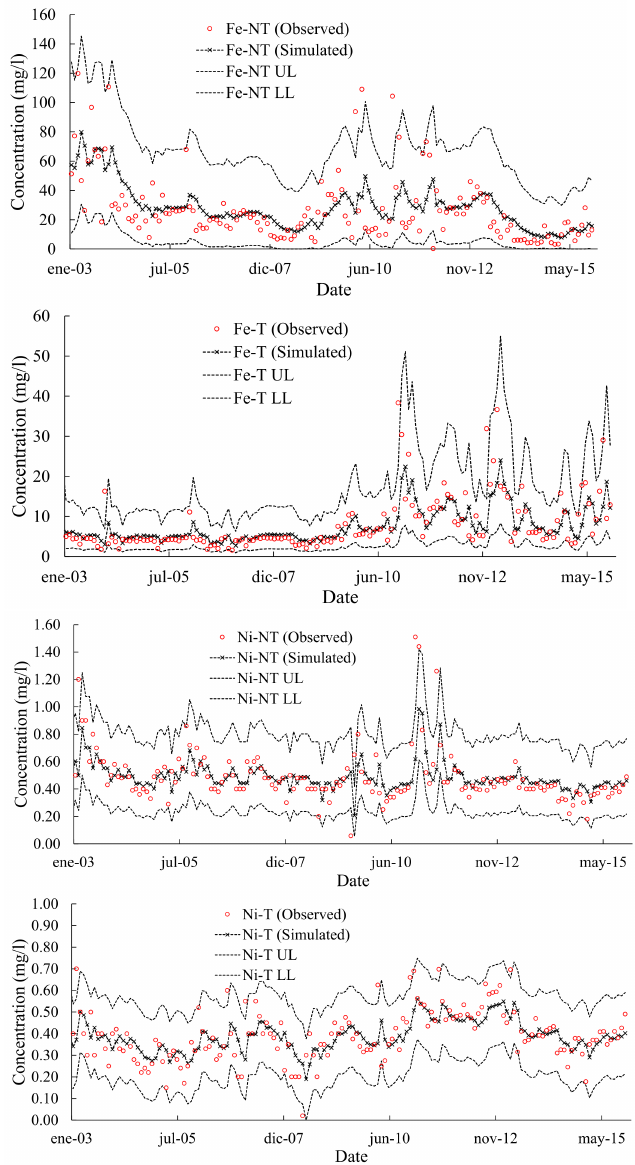
Figure 5. Observed and simulated (ARIMA) values for Fe and Ni concentrations in untreated and treated leachate during the study period. NT = Untreated, T = Treated, UL = Upper limit, and LL = Lower